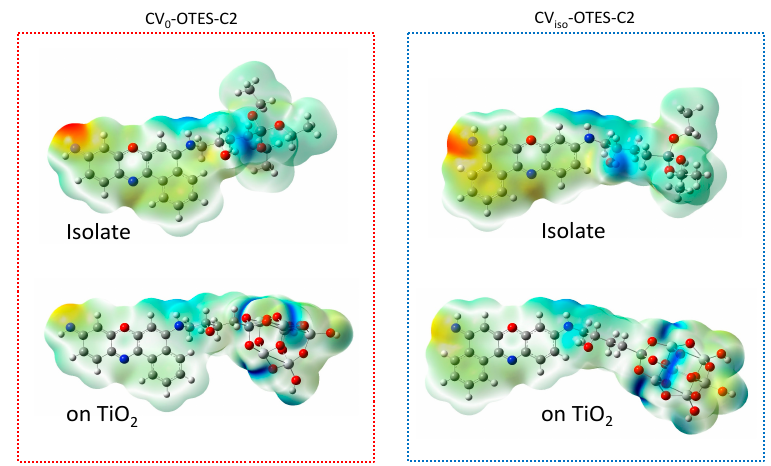
Figure 10. Molecular electrostatic potential (MEP) of isolated CV–OTES–C2 and CV iso –OTES–C2 adsorbed on the TiO 2 cluster using CPCM in EtOH. Red and blue indicate electron-rich (negative charge) and electron-deficient regions (positive charge), respectively; the electrostatic potential increases in the order red < orange < yellow < green < cyan < blue. Color code of the MEP maps of the isolated CV–OTES–C2 and the CV–OTES–C2 adsorbed on the TiO 2 cluster ranged from − 0.078 a.u. to 0.078 a.u. and from − 0.11 a.u. to 0.11 a.u., respectively.